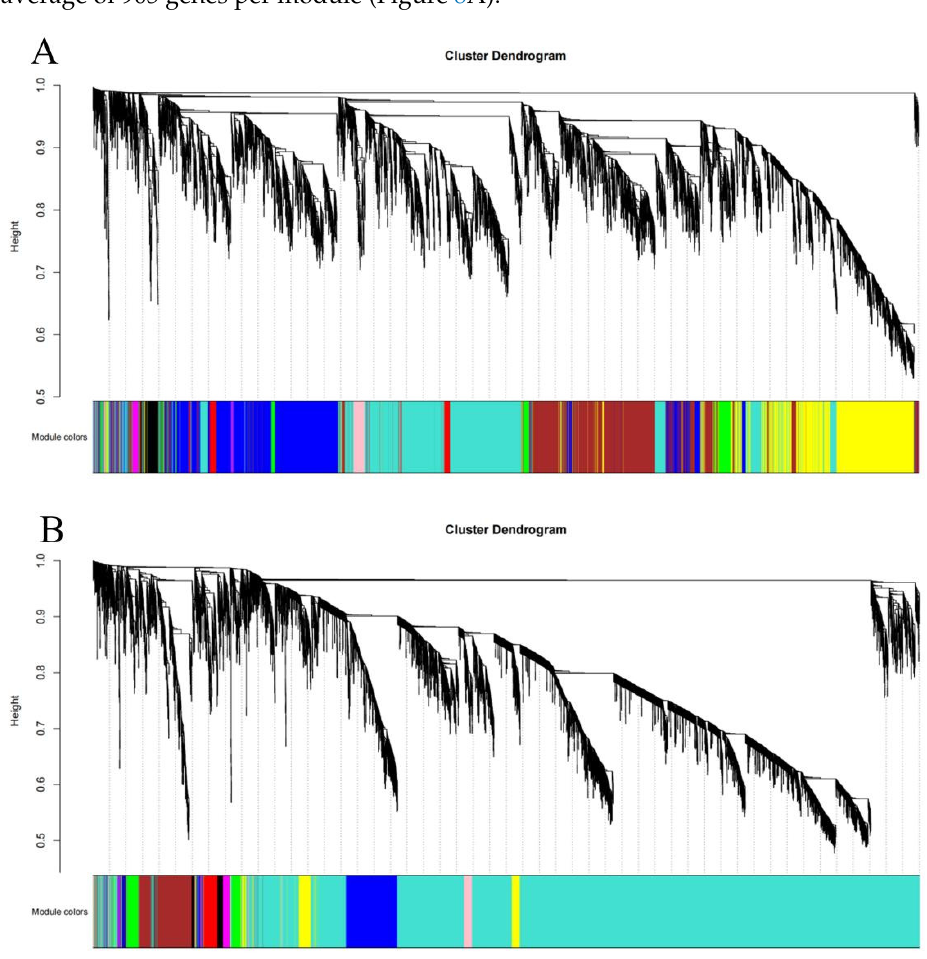
Figure 7. Gene cluster tree and module construction: ( A ) Xinluzao 50 and Xinluzao 50 FLM; ( B ) CSS386 and Sicala V-2.